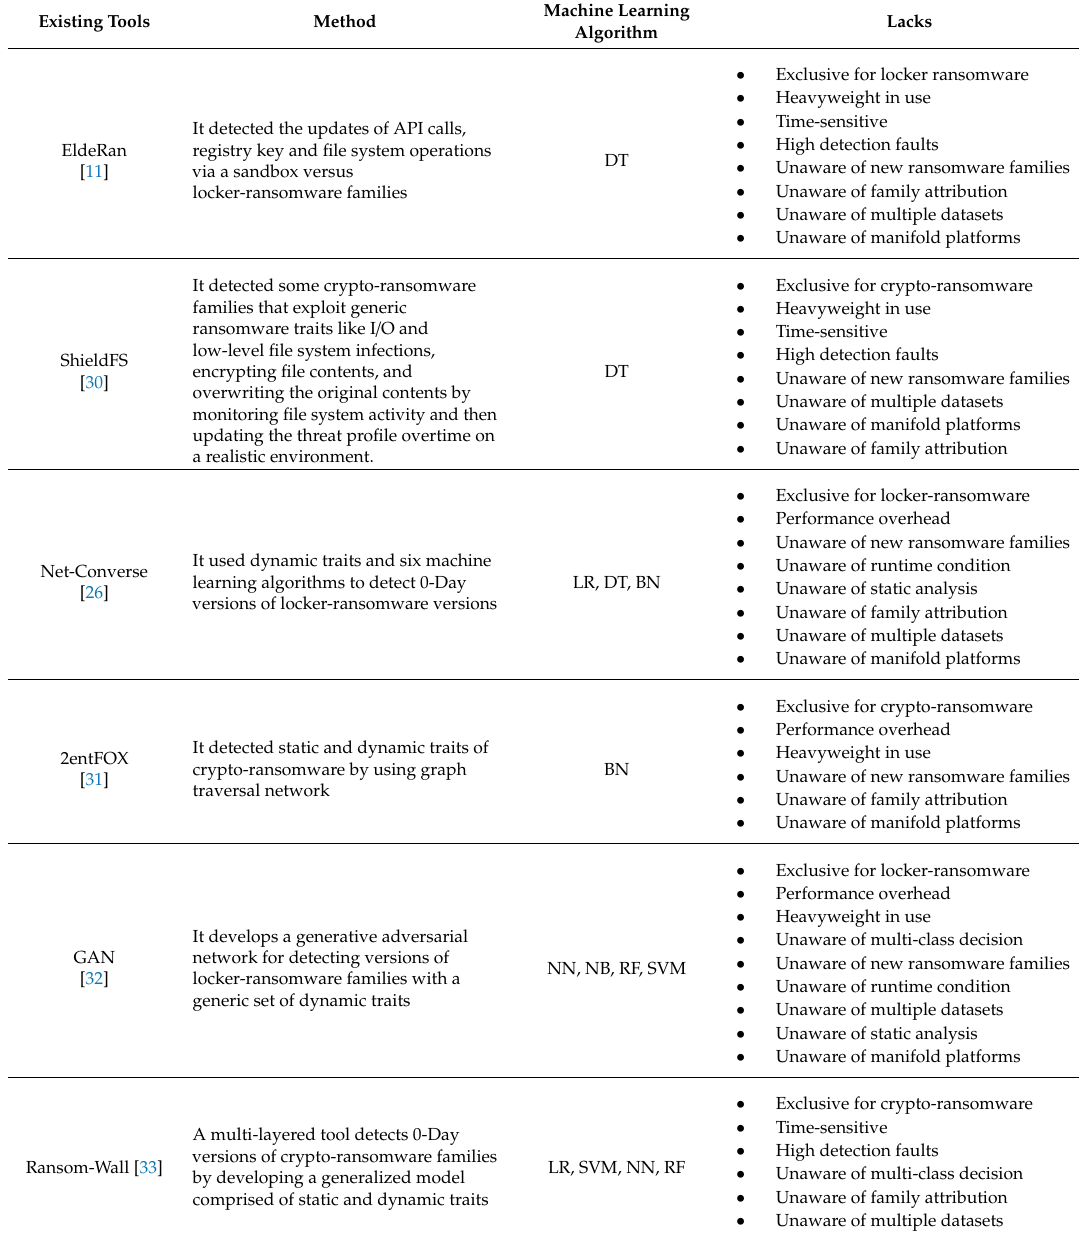
Table 3. Prominent anti-ransomware tools assisted by machine